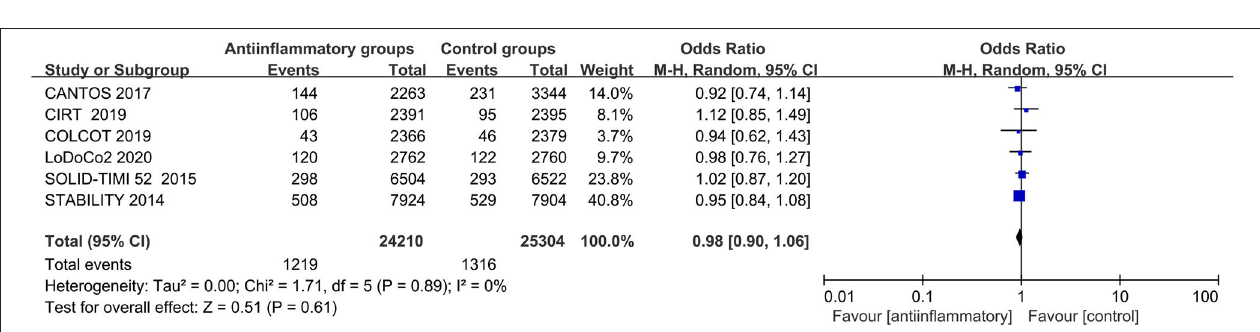
FIGURE 7 | Forest plots of studies evaluating infections in patients receiving anti-inflammatory agents vs. placebo.